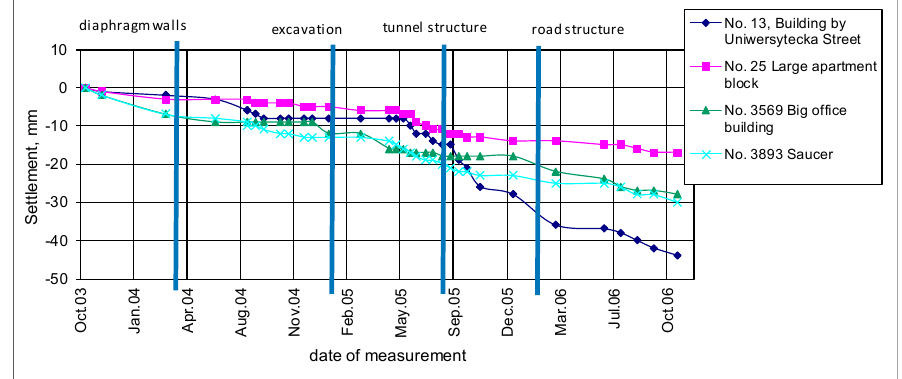
under the roundabout in Katowice).